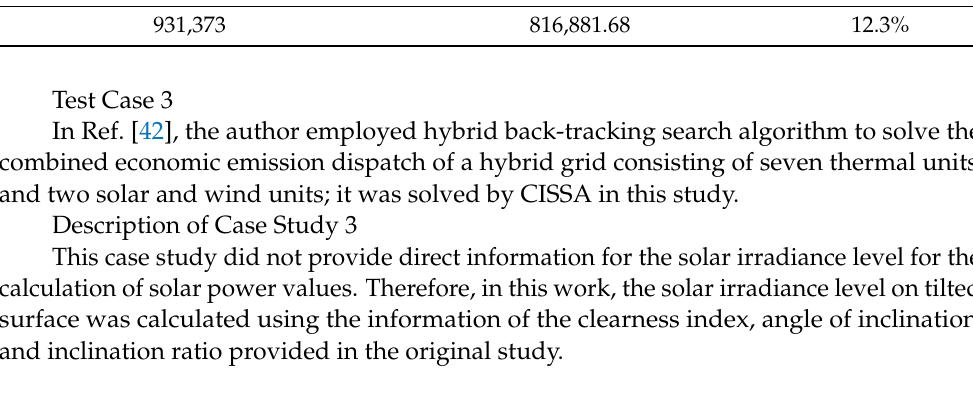
Table 23. Hourly clearness index, ambient temperature, and wind speed — case study 3.